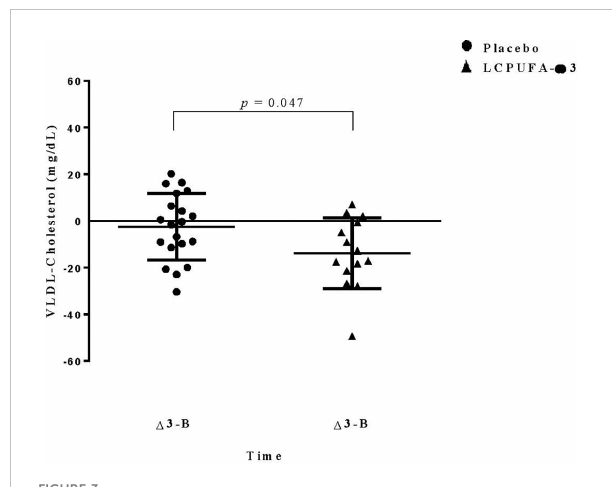
FIGURE 3 Changes in VLDL-Cholesterol levels. Data are expressed as mean ± Standard Deviation (SD). Data represent the differences in VLDL-C during the three months and basal time of treatment. Dependent- sample t-test was performed.